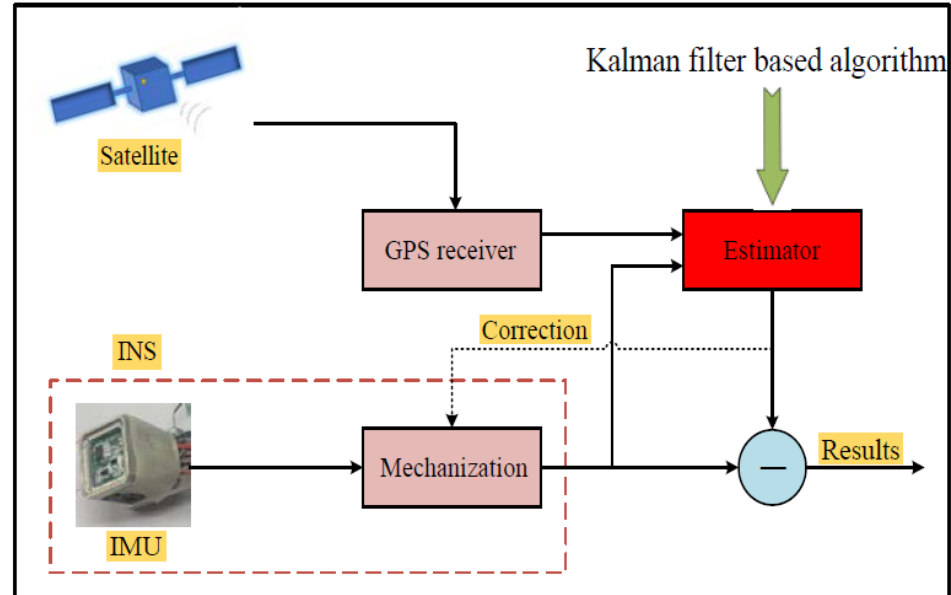
Figure 2. The structure of INS/GPS integrated navigation.